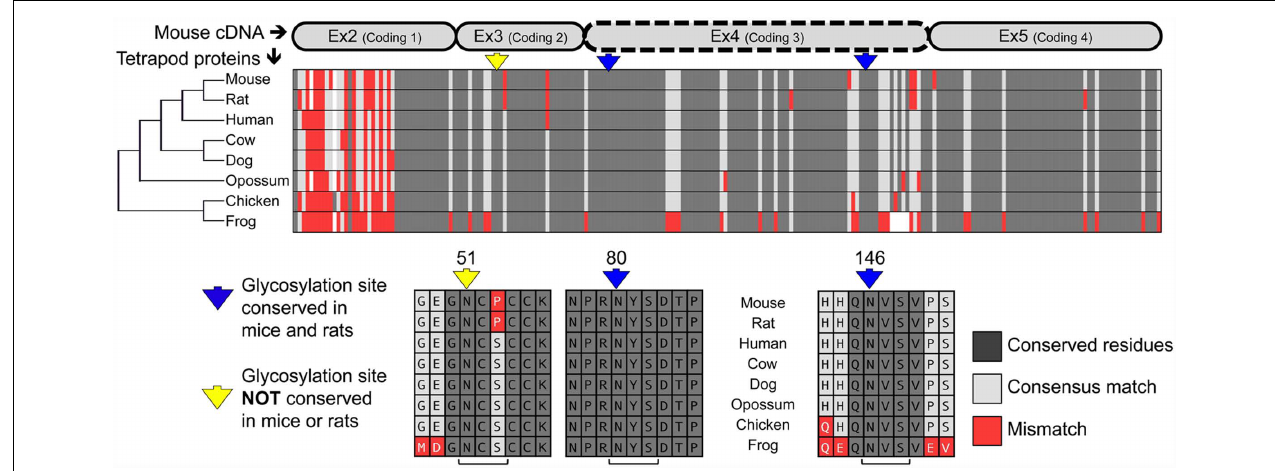
phylogeny.The alignment of the protein sequences to the mouse is shown at the top.The forth exon deleted in a mouse knockout with craniofacial defects (Petryk et al., 2004) is indicated by a dashed line.The N -glycosylation sequons are indicated in context below with brackets at the bottom indicating the N-X-S sequons, while arrows in yellow or blue at the top indicate the asparagines to which sugars can be